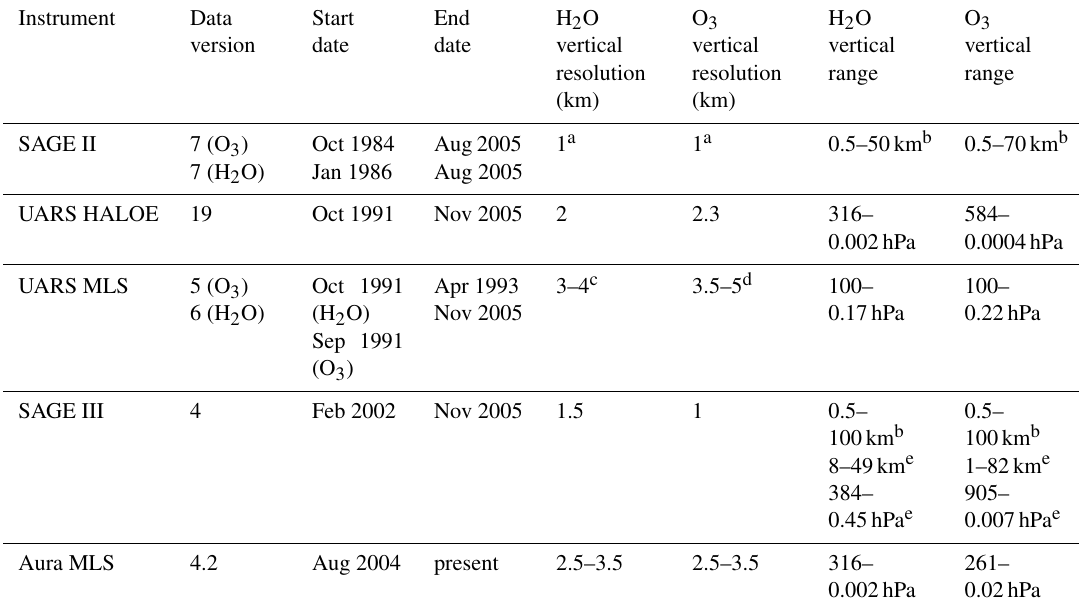
Table 1. Overview of satellite data included in SWOOSH.